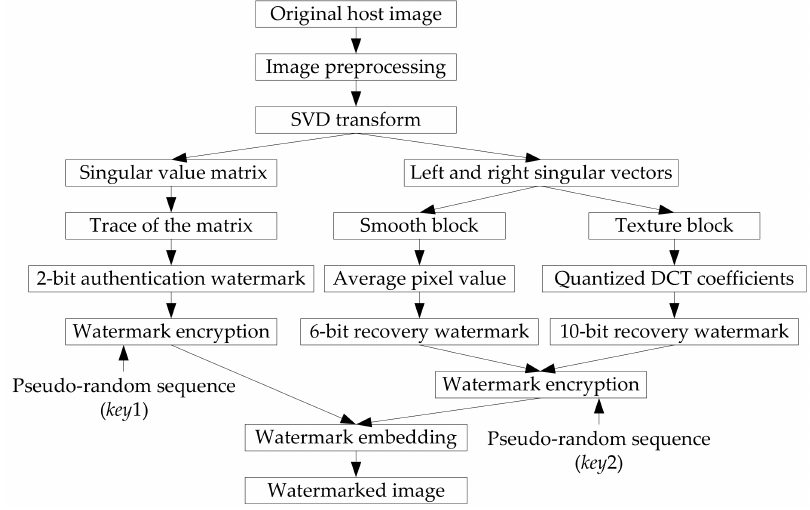
Figure 2. The block diagram of watermark generation and